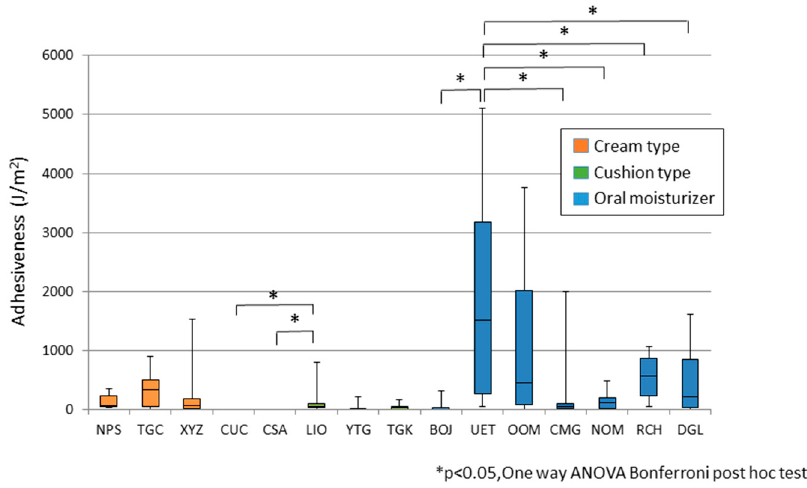
Figure 5. Adhesiveness of seven kinds of denture adhesives and eight kinds of oral moisturizers.